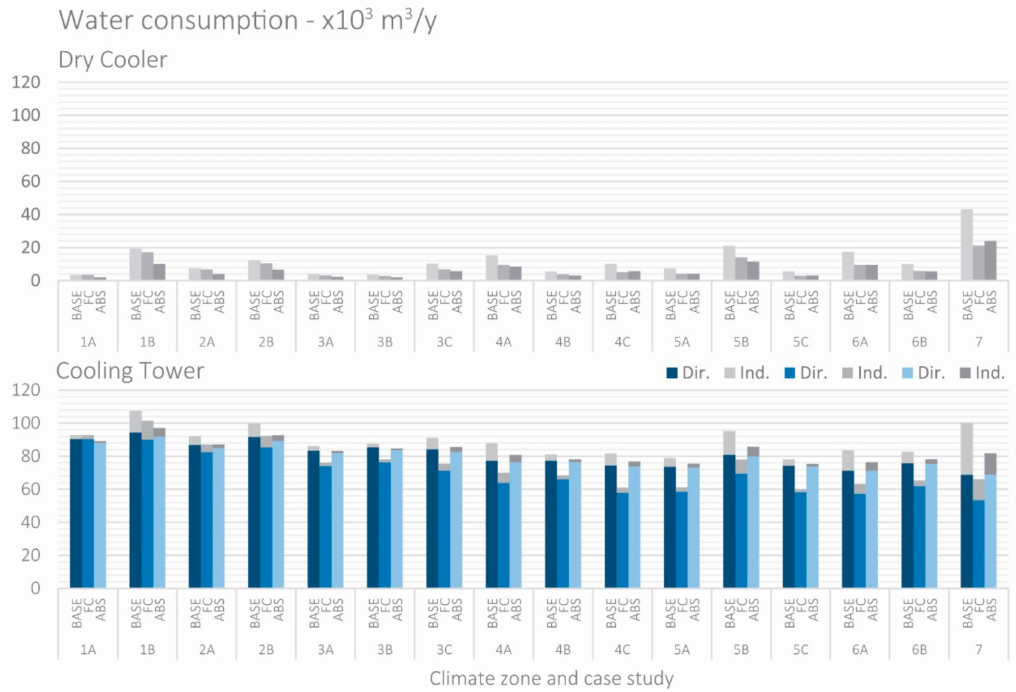
Figure 7. Direct and indirect water consumption based on climate zone and case